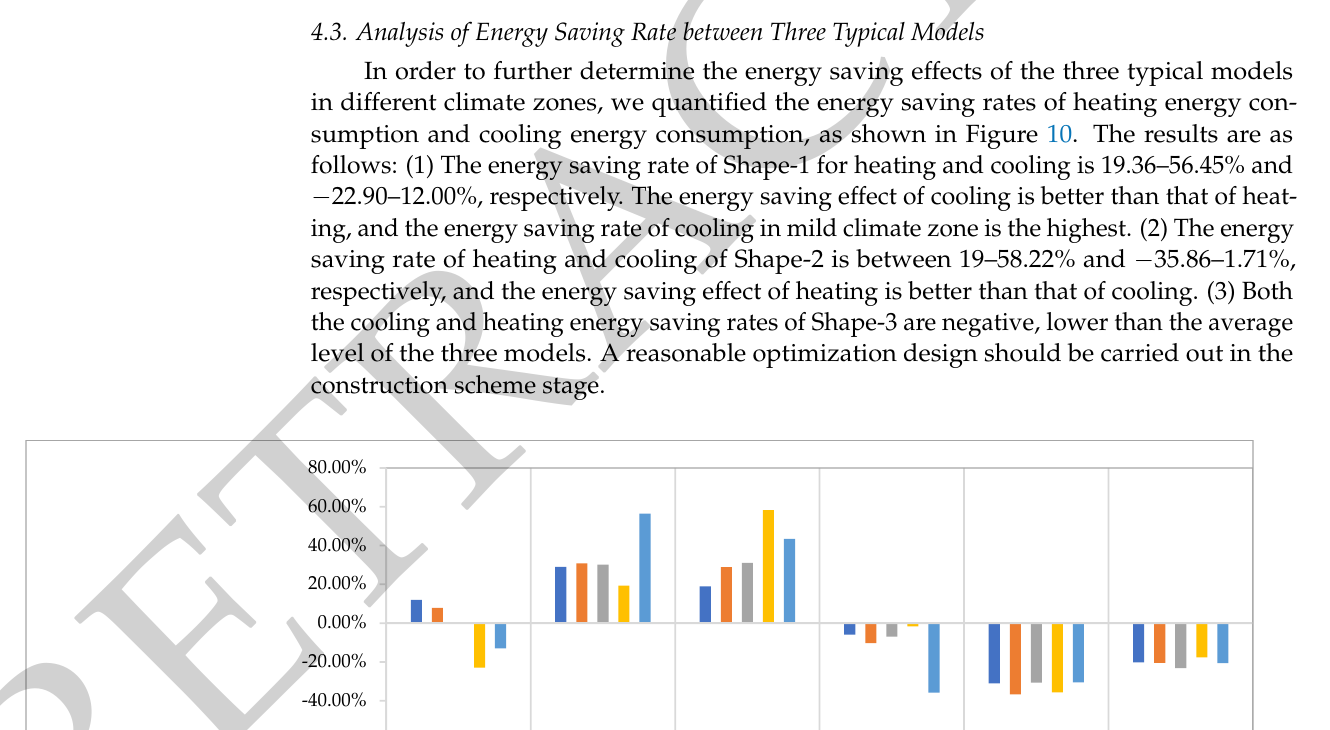
Figure 9. Comparison of simulation results of three typical models in five climate zones.